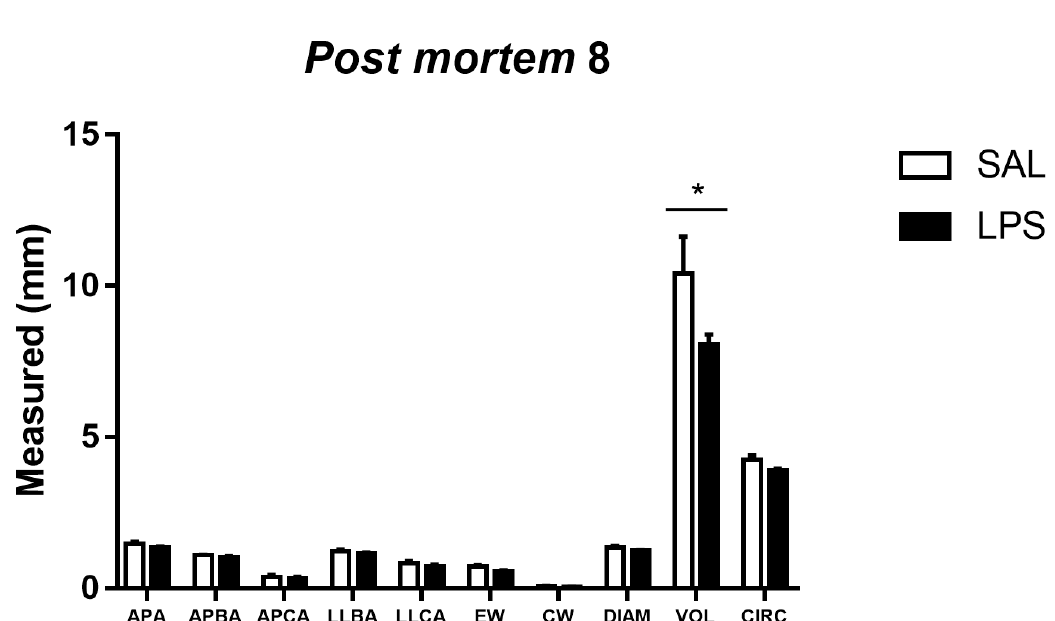
Figure 7. Effects of prenatal exposure to lipopolysaccharide (LPS), compared to the control group (SAL), on the development of rats: reflex ontogenesis (n=20). The evaluation was performed from the 1st to the 21st day of life. Data presented on average ± S.D. *p < 0.05. DR = decubitus recovery; PA = precipice aversion; PG = palmar grasp; AR = acceleration reaction; NG = negative geotaxis.